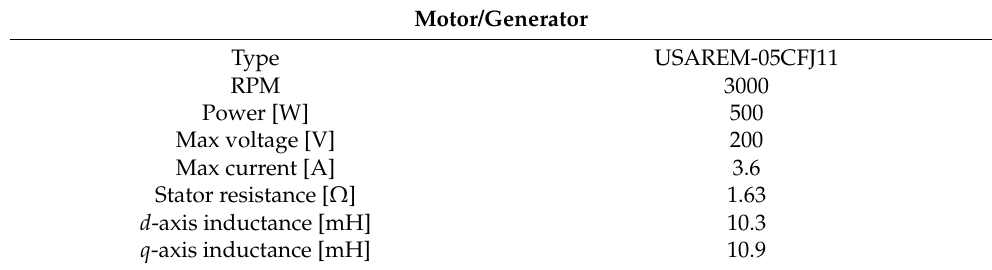
Table 1. Motor and generator/brake parameters.